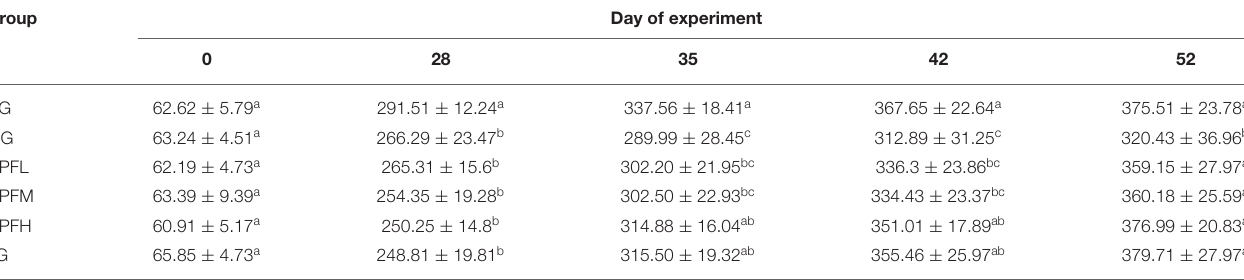
TABLE 5 | The body weight (g) of rats in different groups with time of iron supplementation. Group Day of experiment 0 28